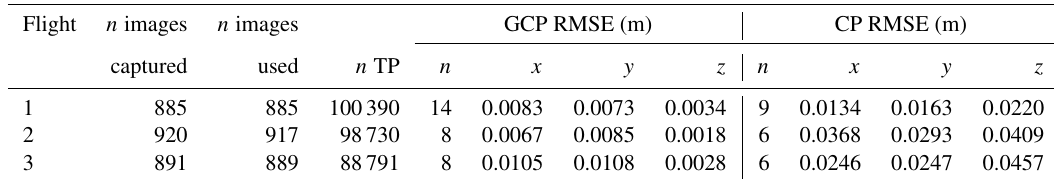
Table 3. Summary statistics for each of the triangulations used to produce DSMs and ortho-mosaics from each of the three flight missions for ground control points (GCPs) and check points